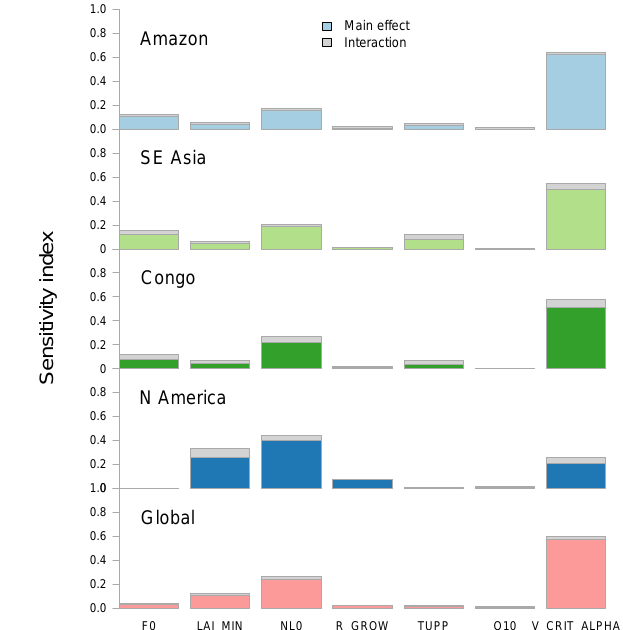
0.00.20.40.60.81.0